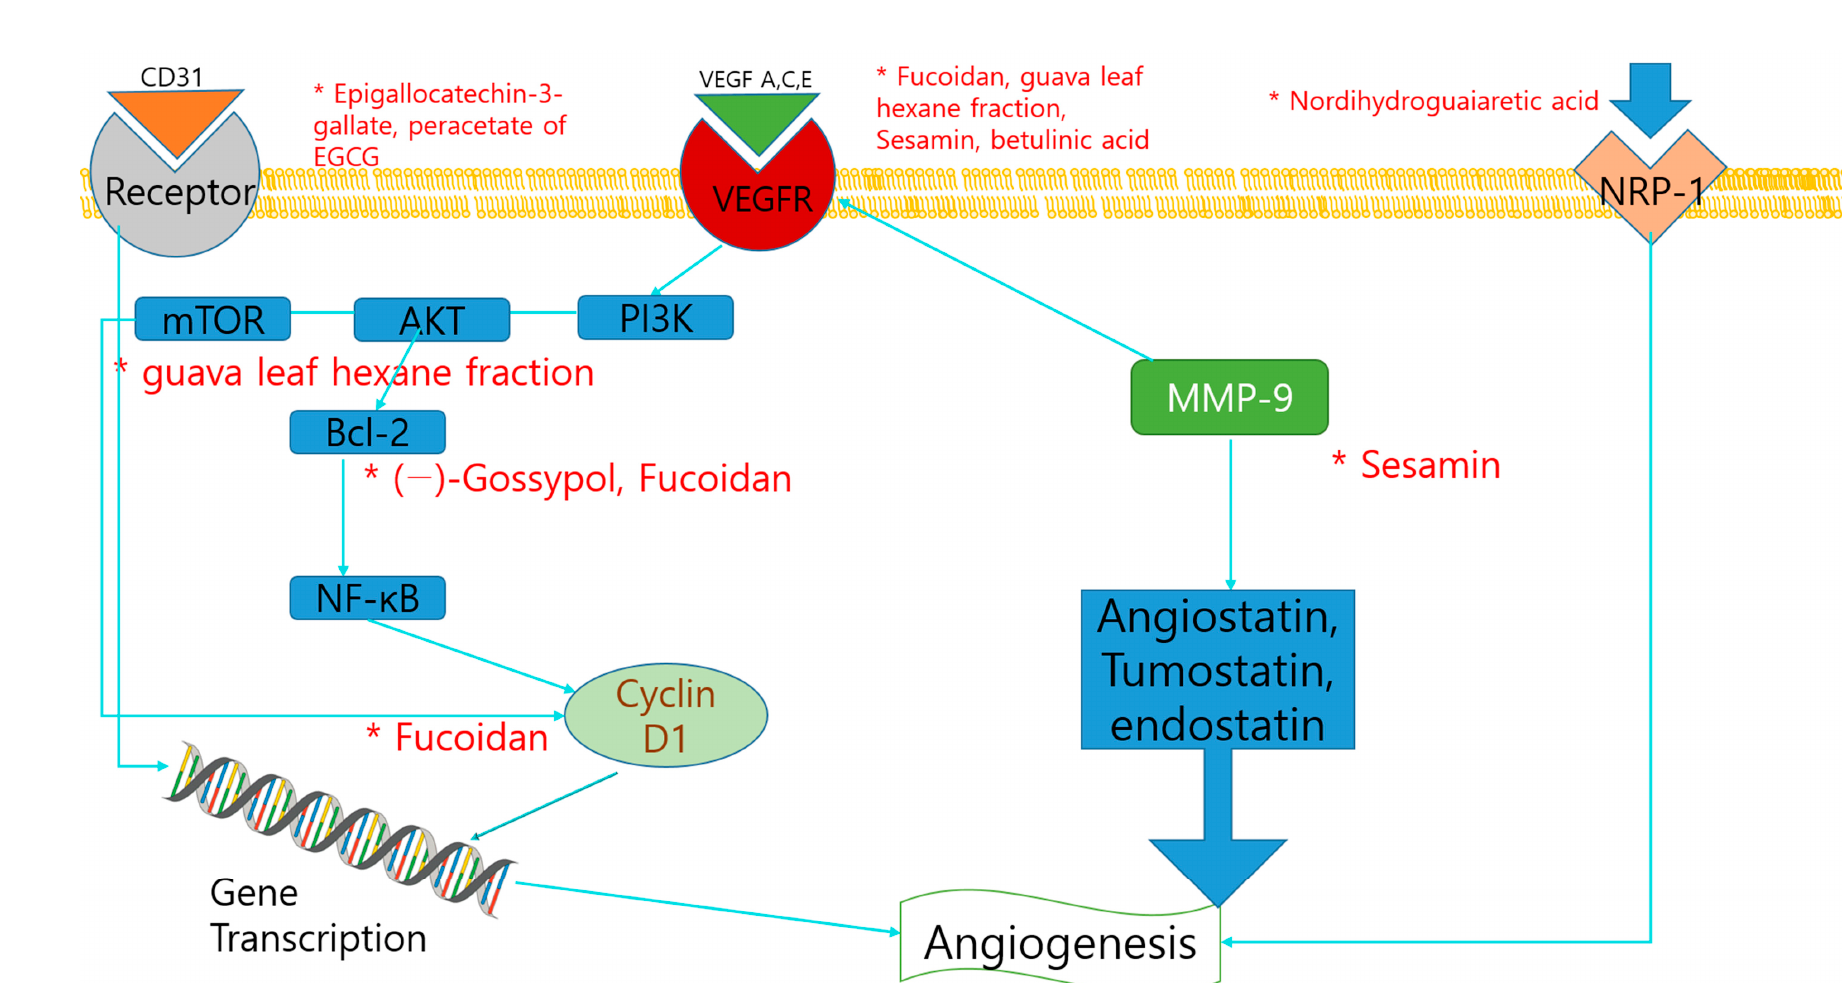
Figure 2. Schematic diagram of anti-angiogenic mechanisms of dietary compounds. *, The molecule is regulated by the compounds. Table 5. Anti-angiogenesis inducing dietary compounds .